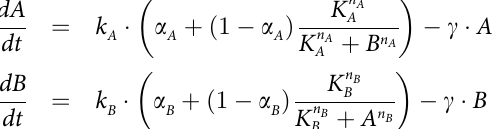
with α = 0.25, k A regulated and selected. In this model f ð A Þ ¼ k